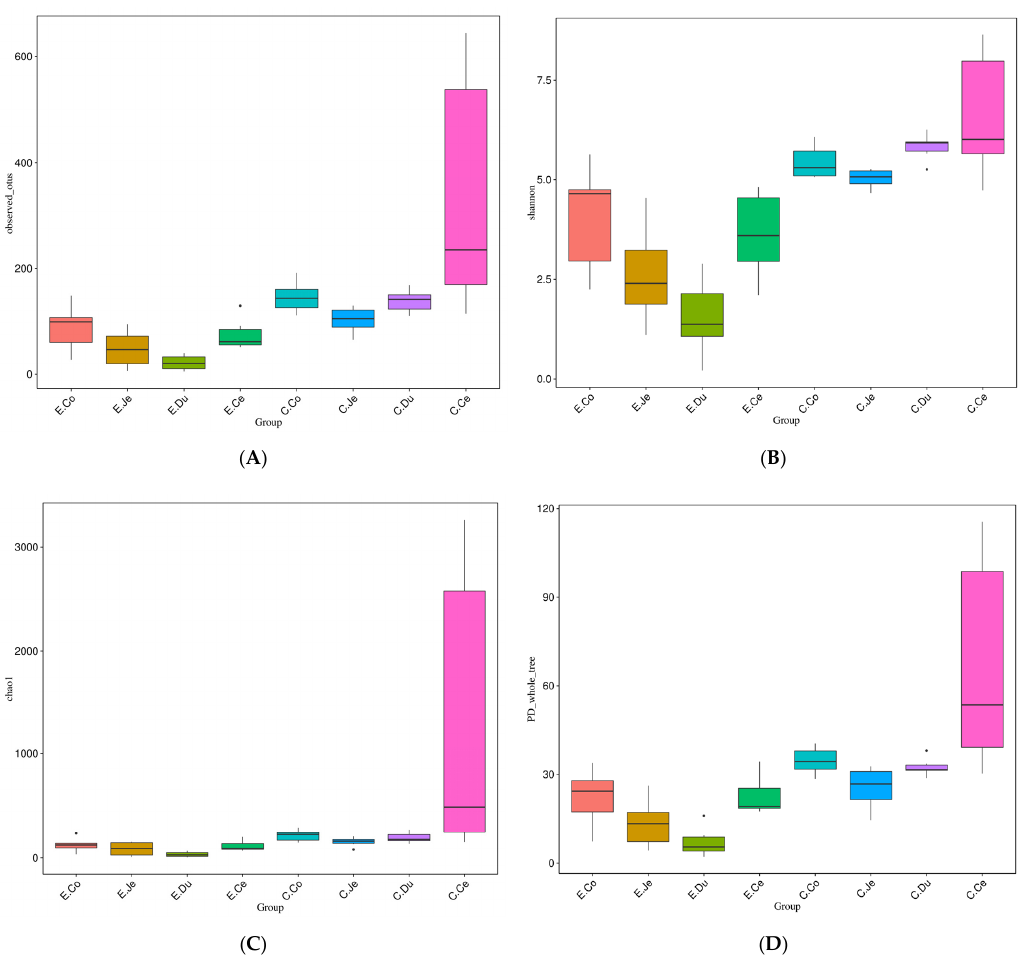
Figure 3. Analysis of alpha diversity index of bacteria of four intestinal segments (FIS) in Dia ( n = 6) and Con ( n = 6) Hyplus rabbits caused by stopping the use of antibiotic diet. ( A ) Observed_OTUs (species) in the four intestinal regions. ( B ) Shannon index of the four intestinal regions. ( C ) Chao1 index of the four intestinal regions. ( D ) PD_whole_tree of the four intestinal regions. C, control group (Con, n = 6); E, diarrhea group (Dia, n = 6), Co, colon; Ce, cecum; Du, duodenum; Je, jejunum.